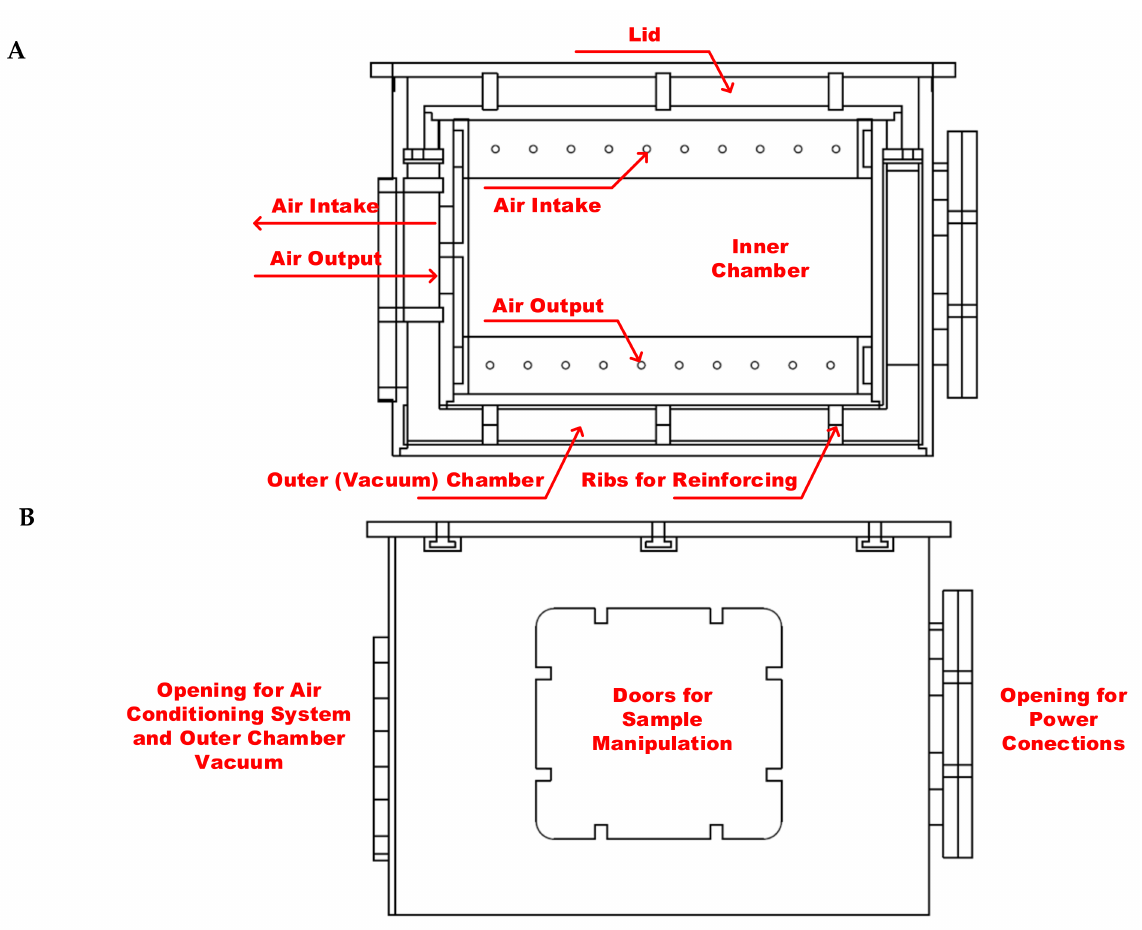
Figure 1. The scheme of thermo incubator ( A )—top view, and its side view ( B ). It is required that temperature during the tests is close to human temperature